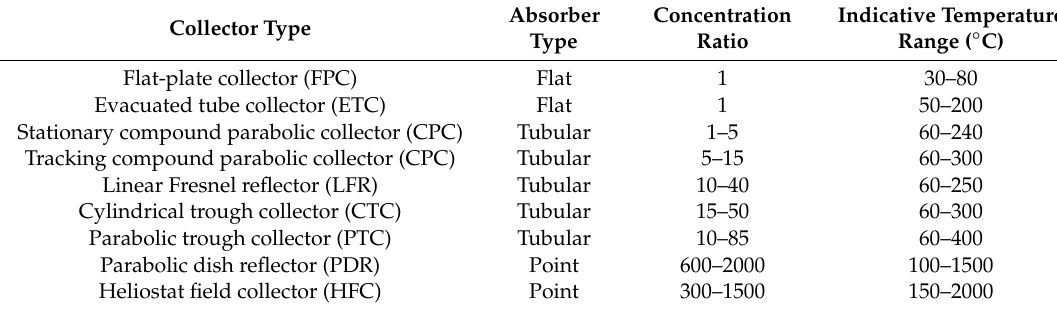
Table 1. Collector types for solar thermal utilization